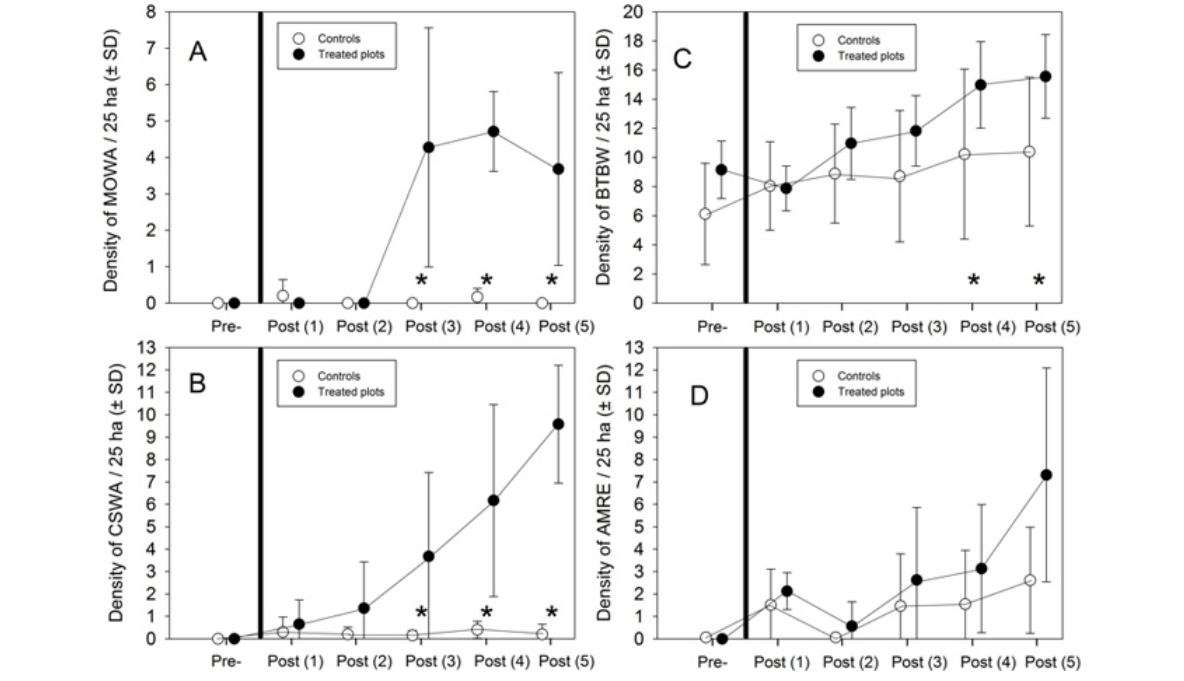
Fig. 5 . Mean (±SD) density of Mourning Warbler, Geothlypis philadelphia (A), Chestnut-sided Warbler, Setophaga pensylvanica (B), Black-throated Blued Warbler, Setophaga caerulescens (C), and American Redstart, Setophaga ruticilla (D) in treated plots and controls during one year preharvest and the first five years postharvest. The solid line delineates the pre- from the postharvest years and asterisks (*) indicate significant year-specific treatment